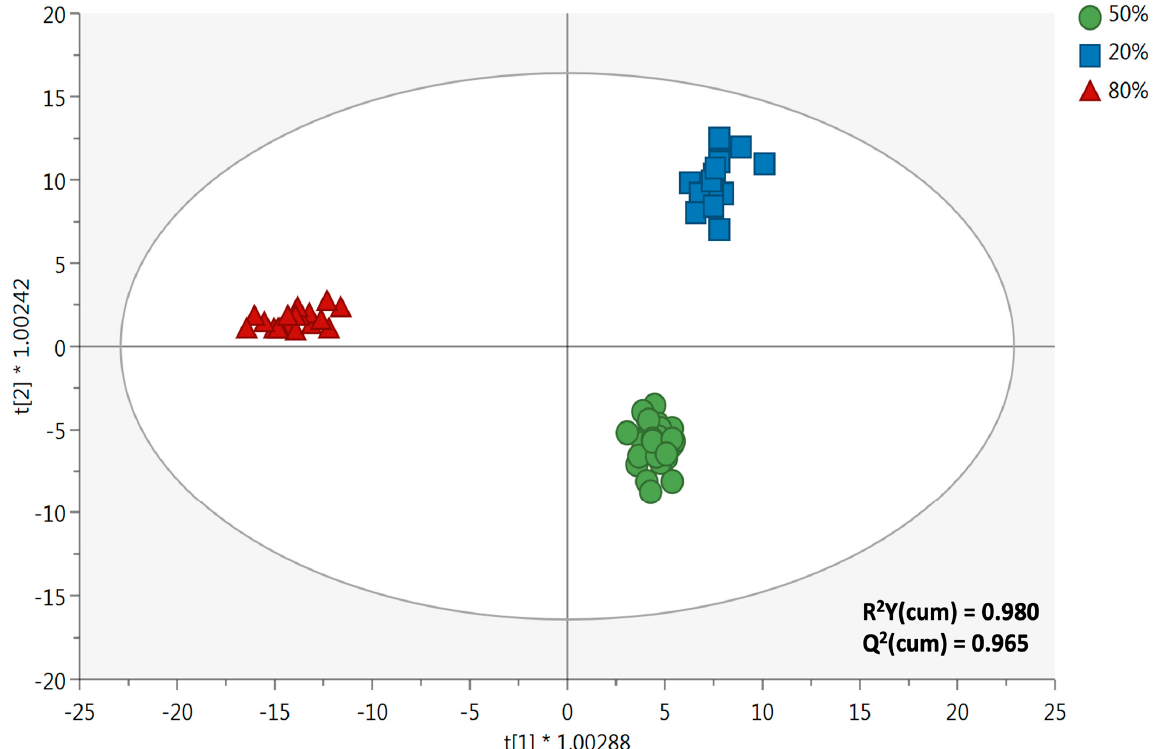
Figure 3. Supervised orthogonal projections to latent structures discriminant analysis (OPLS-DA) score plot, which shows the different duckweed extracts as a function of the % of ethanol used (i.e., 20%, 50%, and 80%). t[1] * 1.00288 and t[2] * 1.00242 are the latent vectors of the OPLS-DA models, used to build the OPLS-DA score plot.